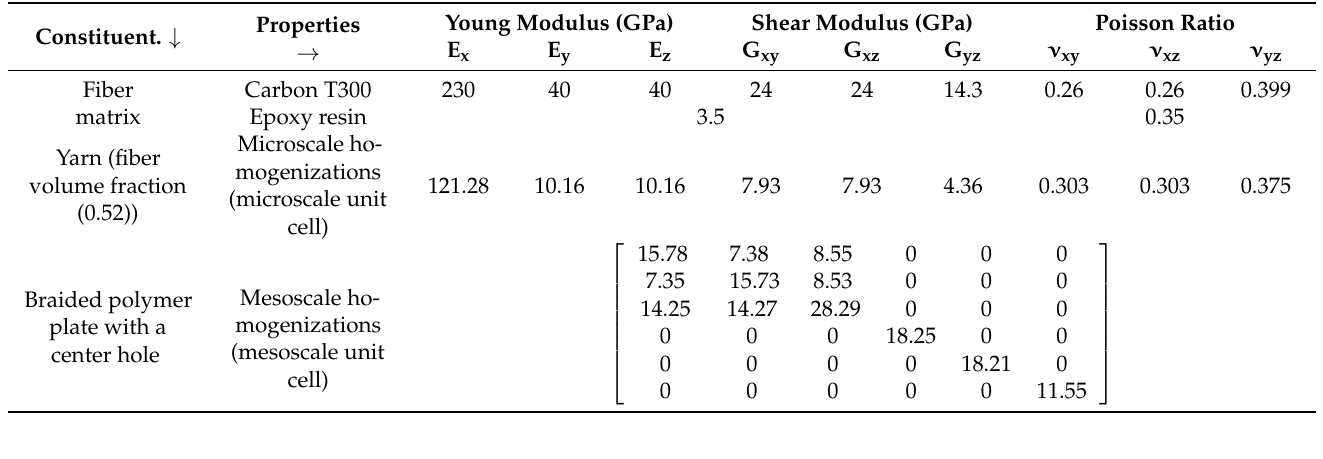
Table 1. Material properties used in the unit cell model in microscale.